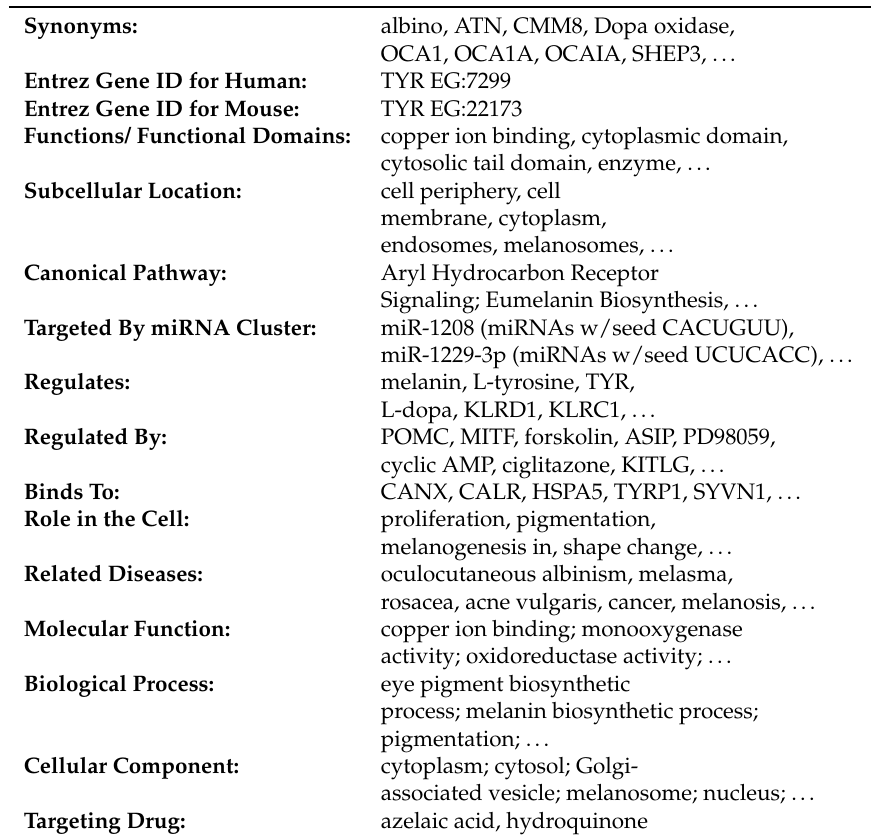
Table 1. Example Data for Tyrosinase Protein, TYR (Partial List of all